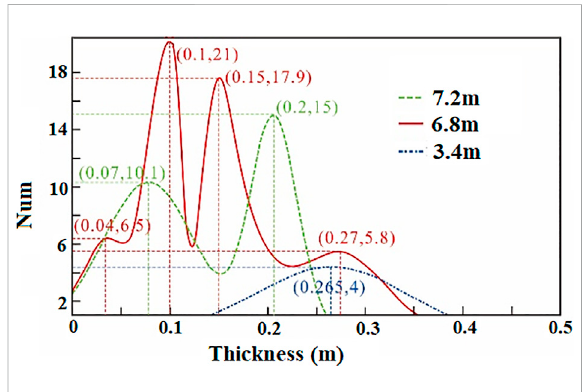
FIGURE 3 Thickness distribution inside the tidal shale layer.